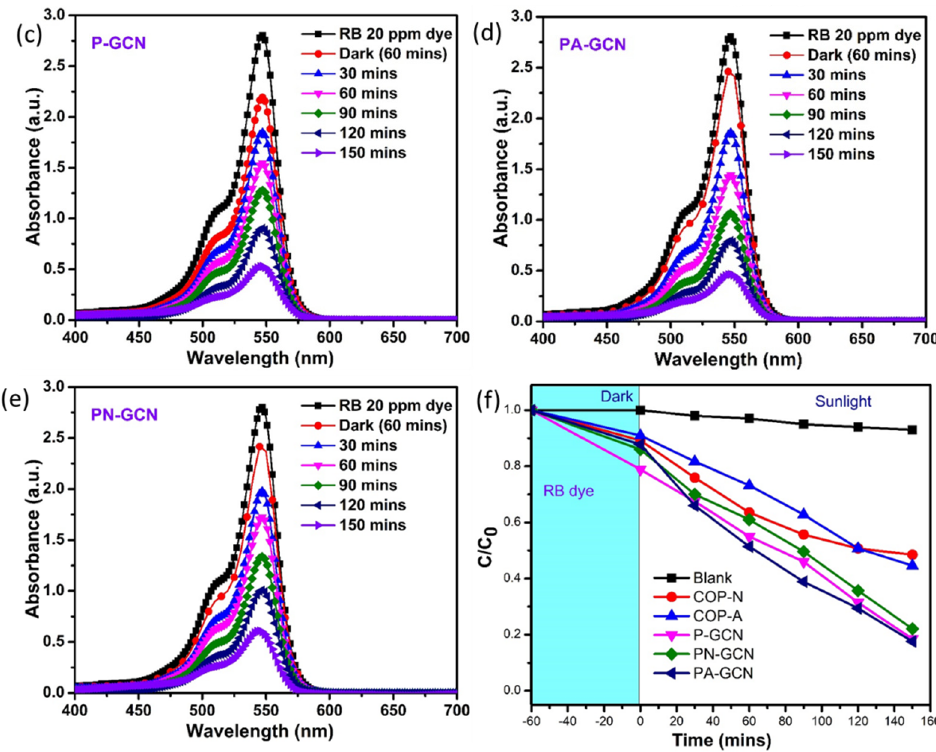
Figure 11. Degradation UV-Vis spectra of RB for the Metal free catalysts ( a ) COP-N, ( b ) COP-A, ( c )